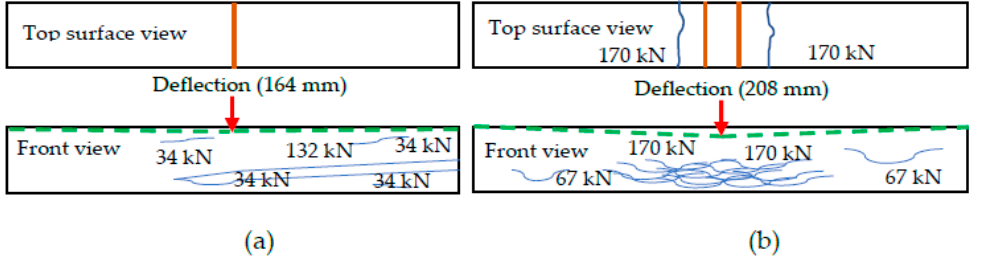
Figure 5. Damage behaviors of full-scale fiber-reinforced foamed urethane (FFU) composite beams under ( a ) single load test at 132 kN; ( b ) repeated load test at ultimate load (170 kN).